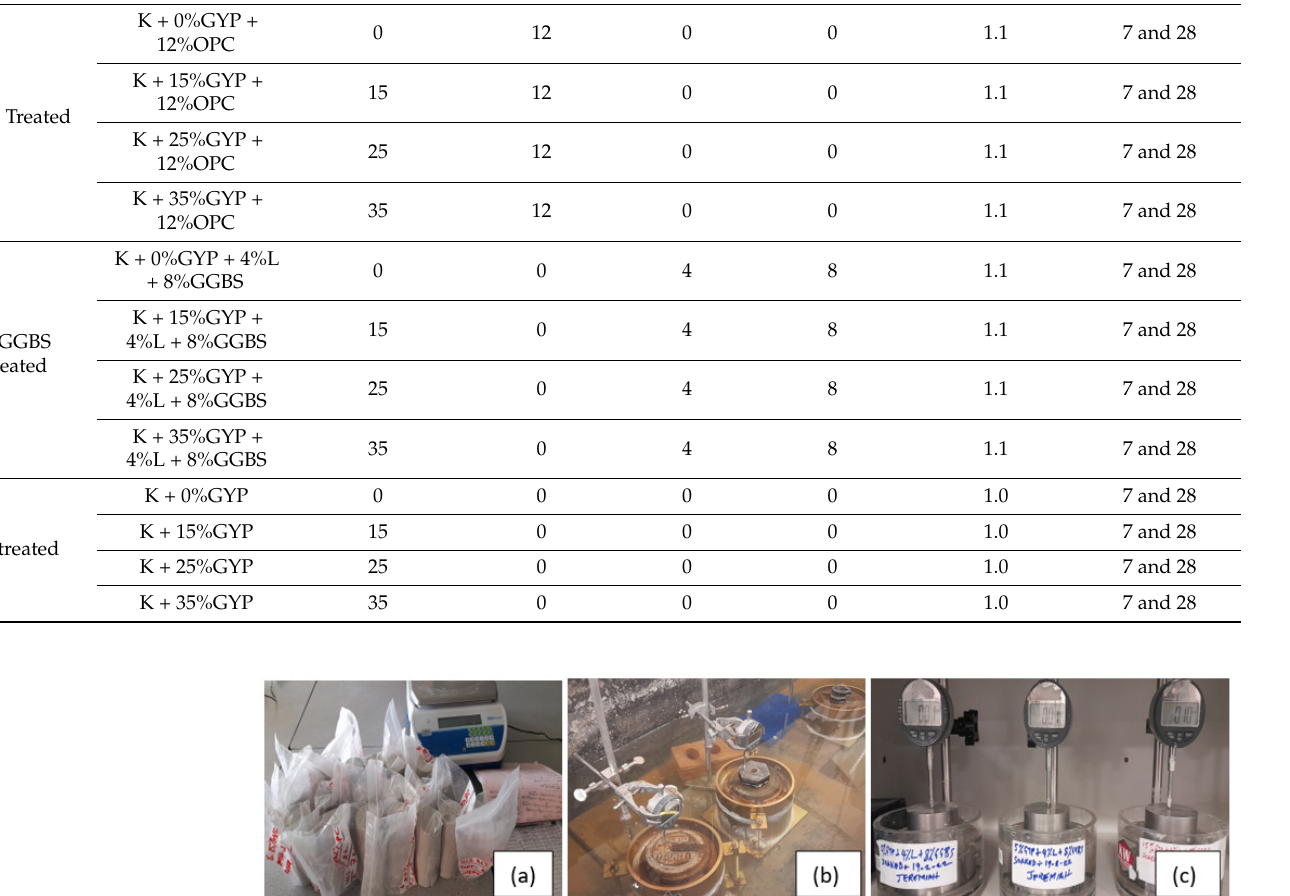
Table 4. Sample mix compositions.